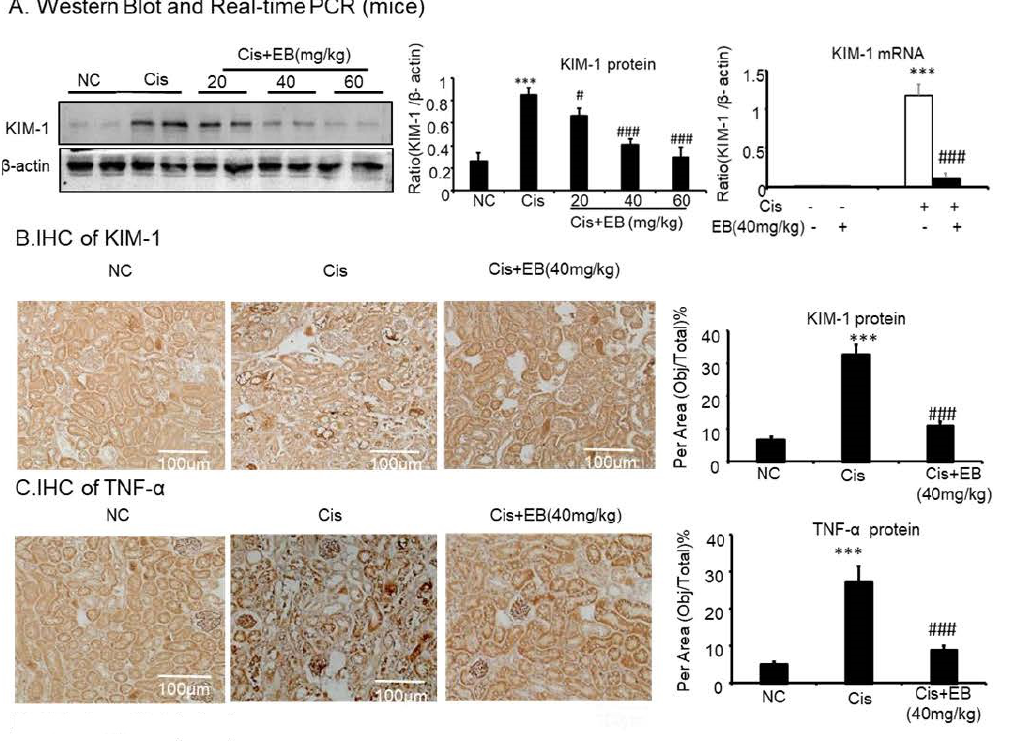
Figure 5. Eleutheroside B attenuated cisplatin-induced renal injury, inflammation, programmed necrosis, and apoptosis in vivo. ( A ) Western blot and real-time PCR analysis of KIM-1. ( B ) and ( C ) Immunohistochemistry of KIM-1 and TNF- α. IHC result and quantitative data indicate that treatment of eleutheroside B reduced the percentage of KIM-1 and TNF- α in injured kidney. ( D ) Western blot analysis and quantitative data of RIPK1, RIPK3, p-P65, and cle-caspase-3. ( E ) Real-time PCR of inflammation indexes. Real-time PCR demonstrate that treatment of eleutheroside B largely